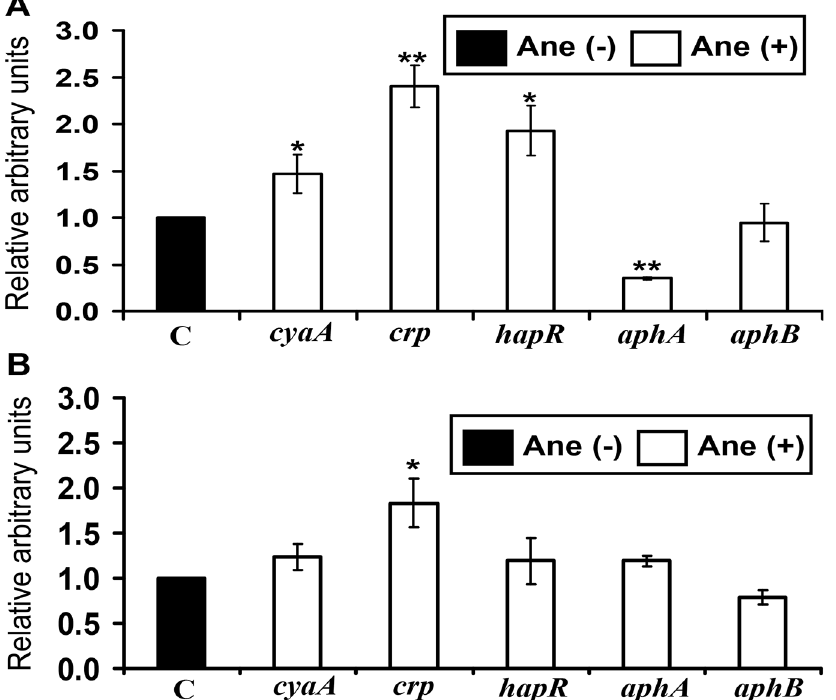
Fig 6. Effect of anethole on the transcription of tcpPH regulatory genes in V . cholerae strain CRC41. Relative transcription level of the tcpPH regulatory genes were examined both in the presence (50 μ g/ml) and absence (0.5% methanol) of anethole, with V . cholerae cells cultured (A) at 4 h of stationary and (B) followed by 2 h of shaking conditions. ‘ C ’ indicates the control value of each target gene transcription, obtained from without anethole sample (arbitrarily taken as 1). Data are presented as the average ± SD of three independent experiments. By using two-sample t -test, a single asterisk ( * ) represents p < 0.05 and a ( ** ) represents p < 0.01 as compared with anethole untreated